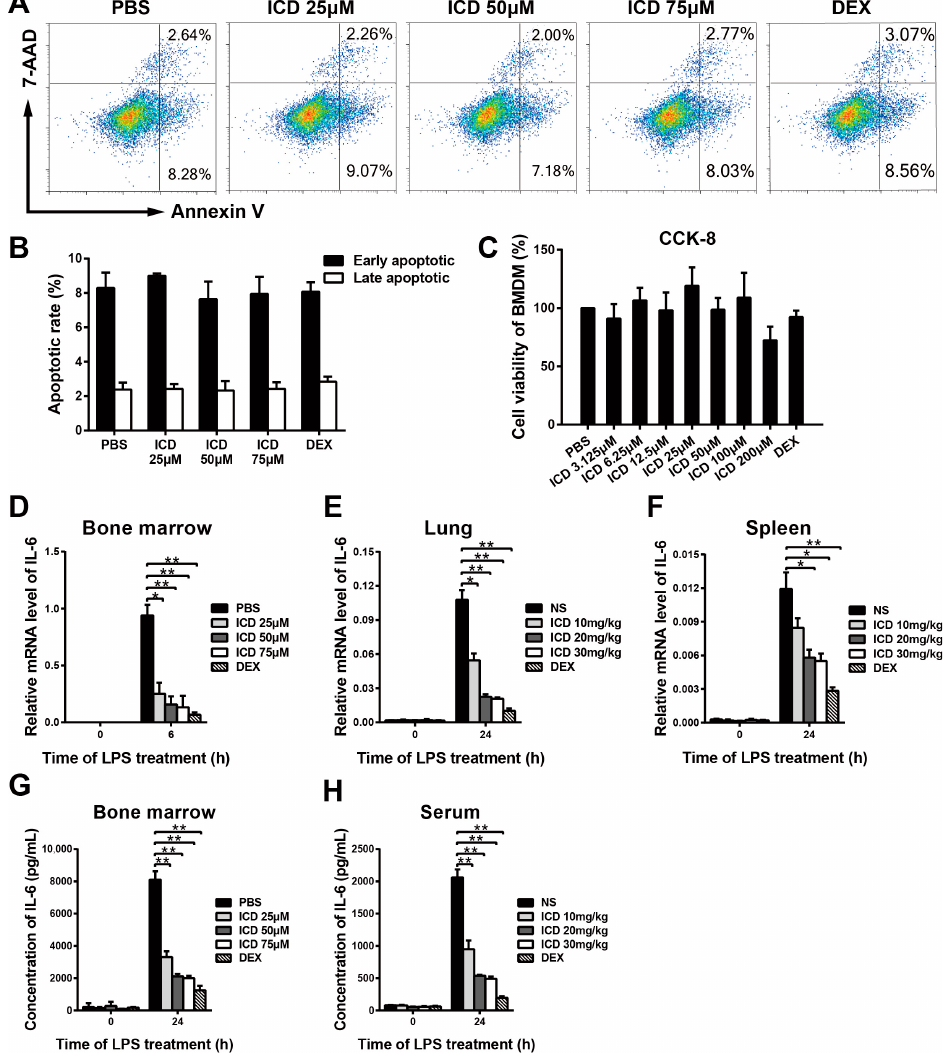
Figure 3. Inhibitory effects of isocorydine on IL-6 mRNA and protein expression in vitro and in vivo. Flow cytometry ( A , B ) and CCK-8 assay ( C ) were performed to evaluate BMDMs viability and apoptosis, after treated with different doses of ICD and DEX (5 μ M) for 24 h. ( D ) The Il6 mRNA expression in BMDMs stimulated with LPS (100 ng/mL) for 0 and 6 h. Before stimulation with LPS, BMDMs were pretreated with different doses of ICD (0, 25, 50, 75 μ M) and DEX (5 μ M) for 1 h. ( E , F ) The Il6 mRNA expression in lung and spleen tissues of mice with LPS-induced acute lung injury. ( G ) The protein levels of IL-6 in supernatants of BMDMs stimulated with LPS (100 ng/mL) for 24 h. Before stimulation with LPS, BMDMs were pretreated with ICD (0, 25, 50, 75 μ M) and DEX (5 μ M) for 1 h. ( H ) The protein level of IL-6 of blood serum of mice with LPS-induced acute lung injury. In ( E , F , H ), the dose of LPS was 25 mg/kg, the doses of ICD were 0, 10, 20, 30 mg/kg and the dose of DEX was 5 mg/kg. The mean and SD of at least three independent experiments are shown. * p < 0.05, ** p < 0.01 indicate significant differences between groups, as determined by a two-tailed paired Student’s t -test. 2.3. ICD Suppresses Inflammatory Pathways in LPS-Activated Macrophages To uncover the mechanisms by which ICD affect inflammation activities in macro- phages, we compared the transcriptomes of control and ICD-pretreated macrophages af- ter stimulation with LPS by high-throughput sequencing of cDNA libraries (RNA-seq).